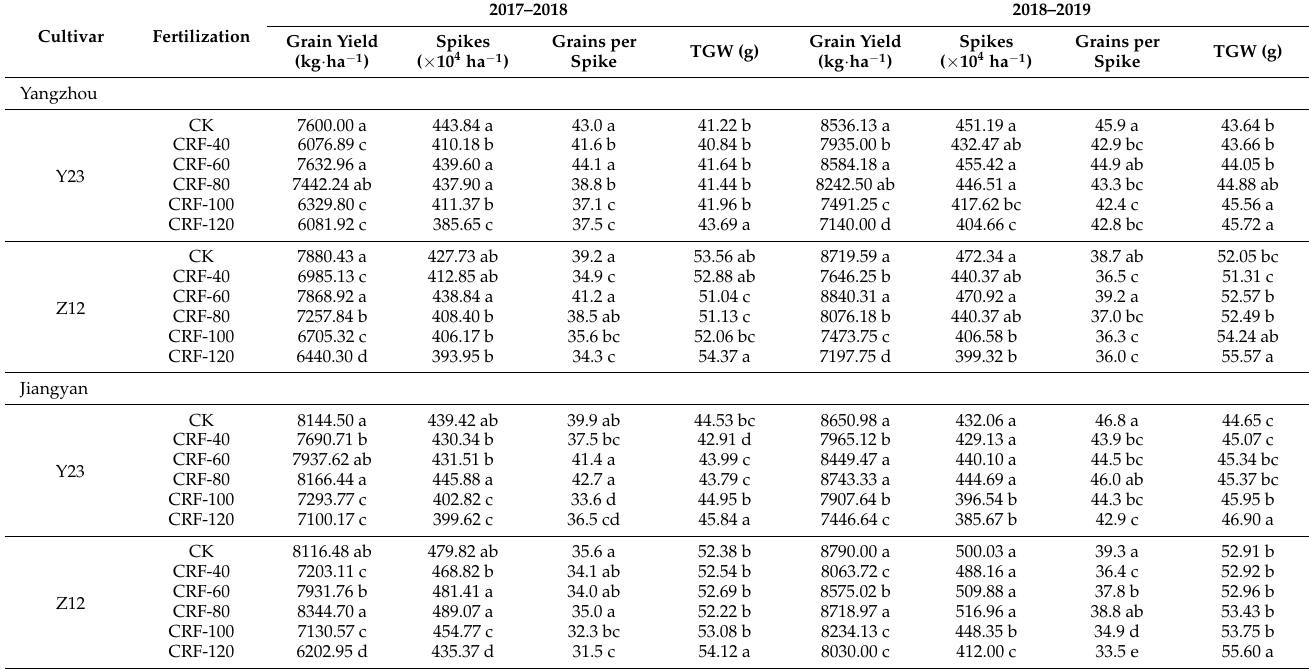
Table 4. Grain yield and yield components in different CRF treatments in Yangzhou and